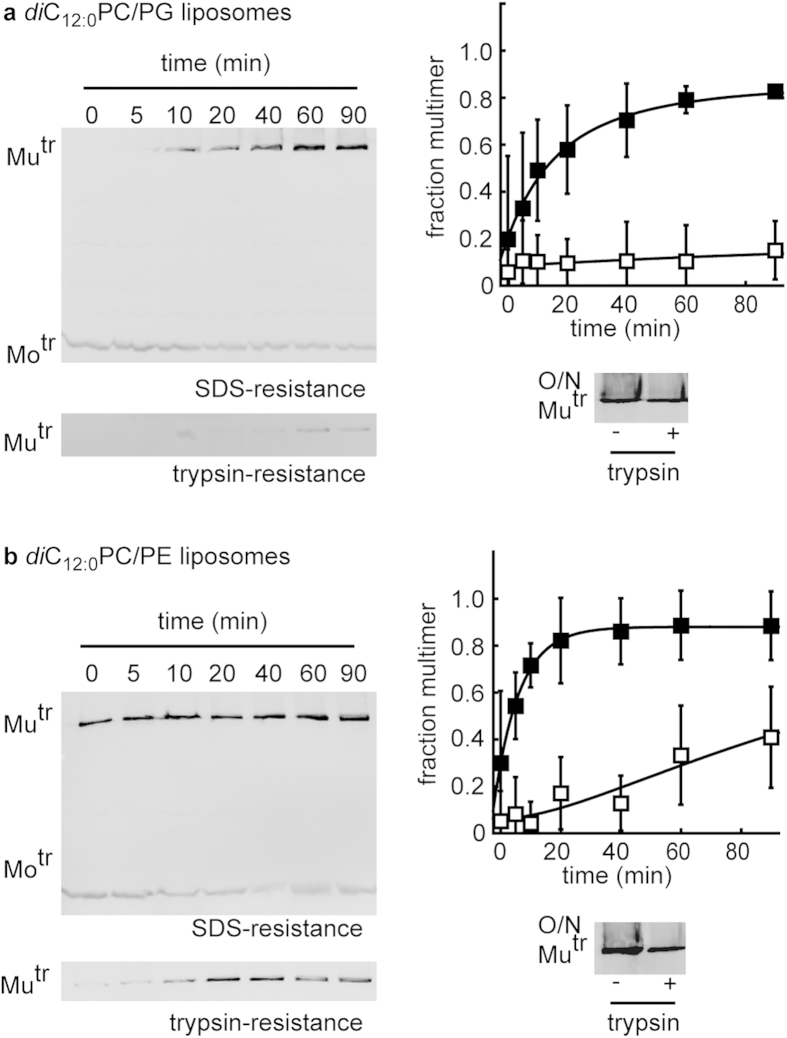
Kinetics of PulD28–42/259–660 folding in C12:0-liposomes containing heterogeneity in the lipid headgroups.(a) Multimerisation kinetics by acquisition of SDS- (◼) and trypsin- (◻) resistance in the presence of 53 mM diC12:0-phosphatidylcholine (PC/PG) liposomes (60/40 mol/mol). (b) Multimerisation kinetics by acquisition of SDS- (◼) and trypsin- (◻) resistance in the presence of 53 mM diC12:0-phosphatidylcholine/ethanolamine (PC/PE) liposomes (90/10 mol/mol). Errors represent S.D. over 3 independent measurements. (a,b) also show trypsin-resistance after overnight (O/N) incubation in the respective liposomes. Mutr and Motr indicate the migration position of multimeric and monomeric PulD28–42/259–660 species, respectively.